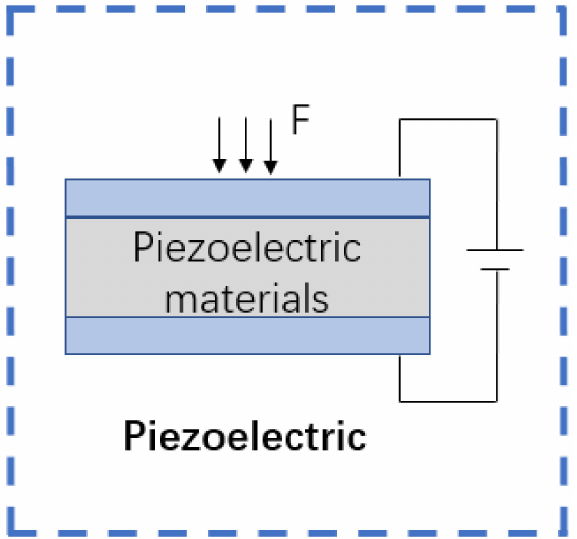
Figure 5. Diagram of the signal conversion mechanism of a piezoelectric flexible